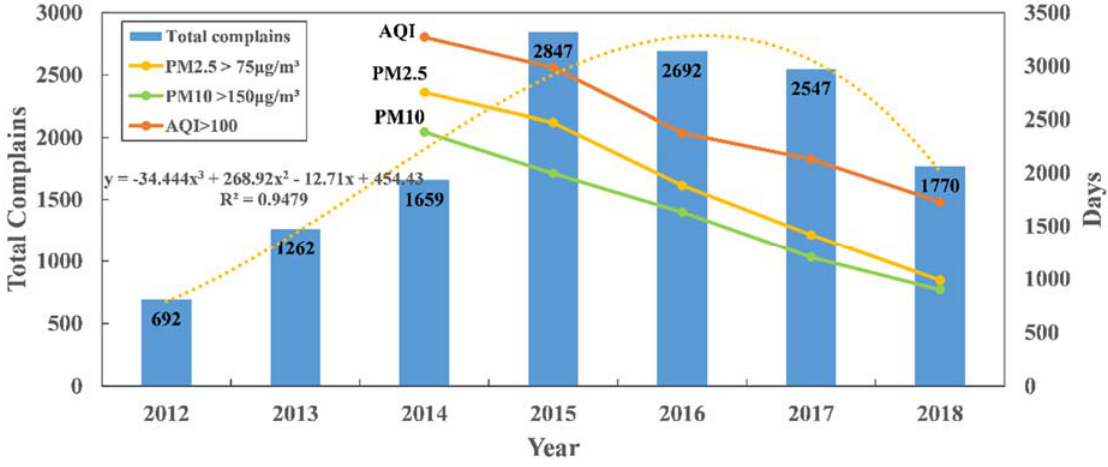
ISPRS Int. J. Geo ‐ Inf. 2021 , 10 , x FOR PEER REVIEW